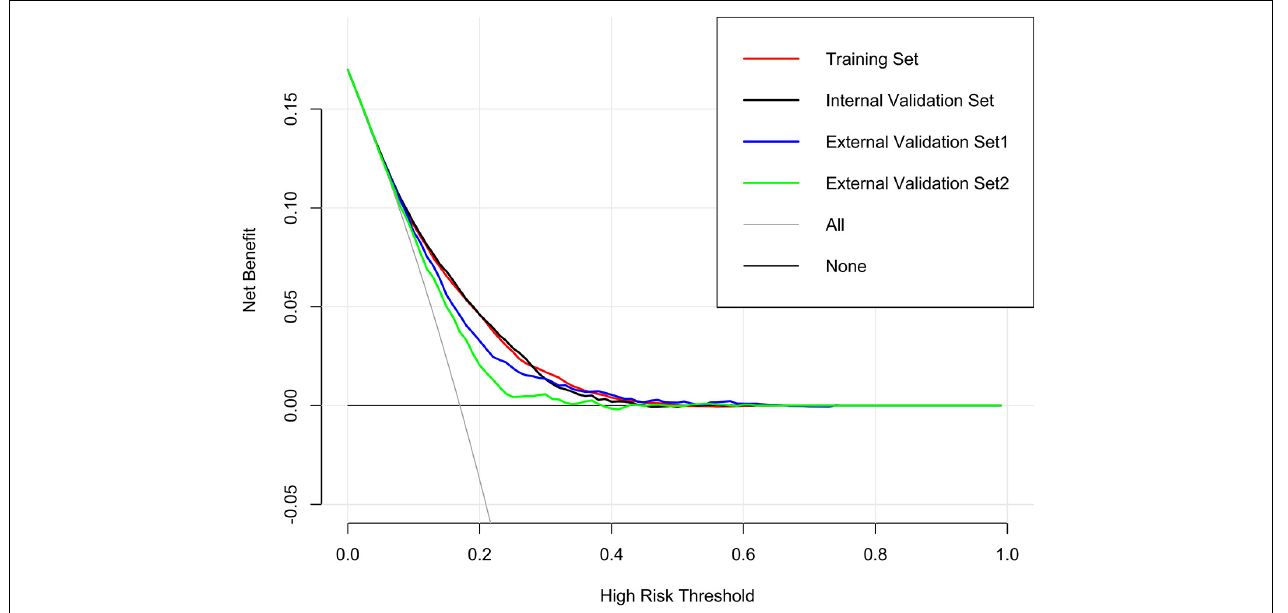
FIGURE 5 | Decision curve analysis (DCA) of the nomogram in training set, internal validation set, external validation set1 and external validation set2.